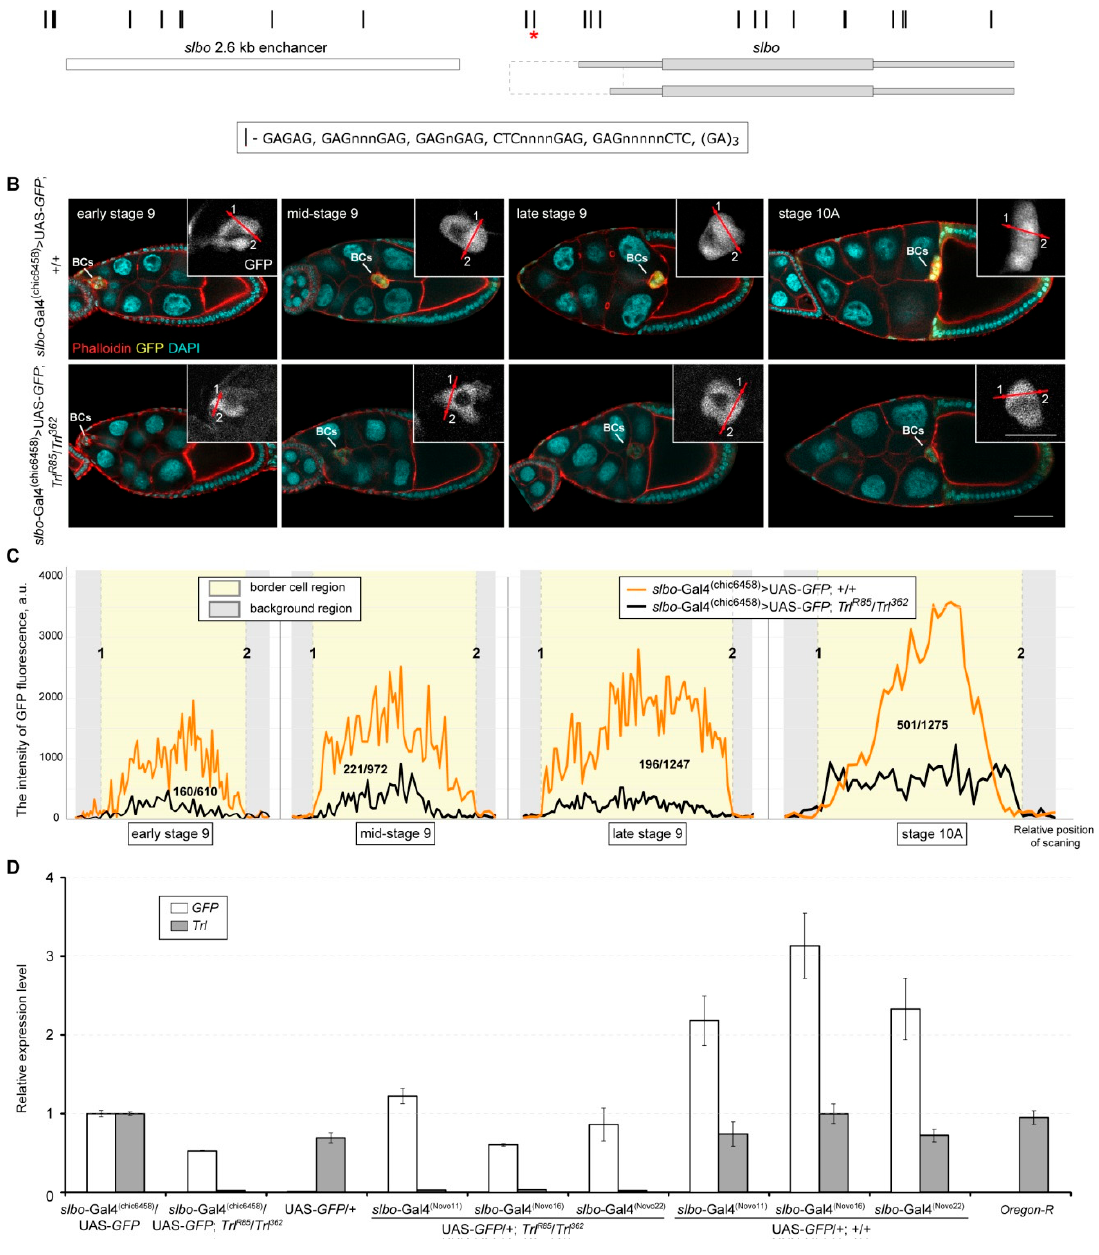
Figure 3. slbo -Gal4-driven GFP expression is dependent on GAGA. ( A ) A schematic map of the slbo locus on chromosome 2R. The gene is shown on the plus strand for convenience; its coding